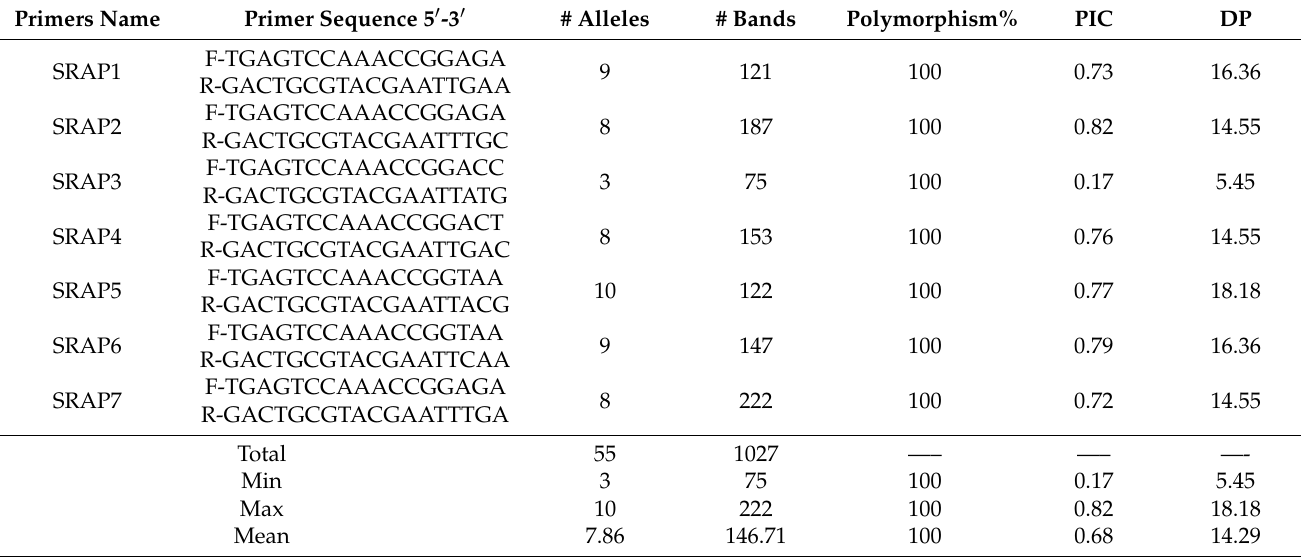
Table 1. Features of SRAP amplified products used to analyze genetic diversity in Hail tomato